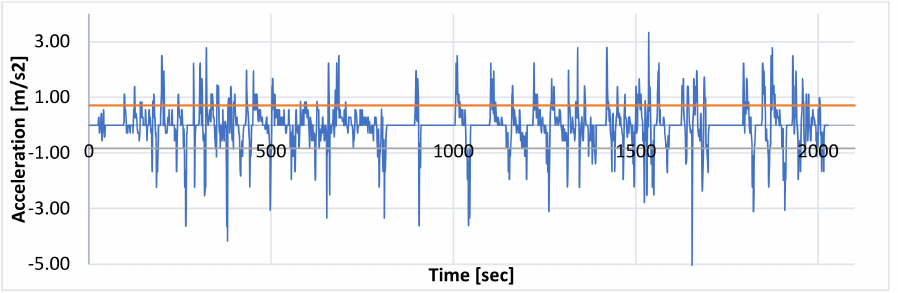
Figure 3. Acceleration values in the “eco” mode with highlighted average values for braking and